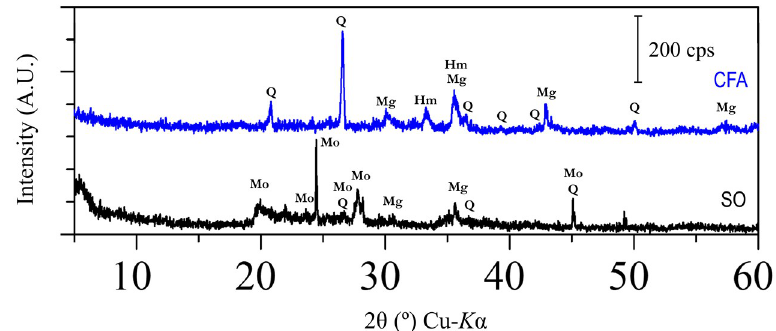
Figure 4. XRD pattern of soil (SO) and coal fly ash (CFA) (Mo—Montmorillonite; Q—Quartz; Mg—Magnetite; Hm—Hematite).